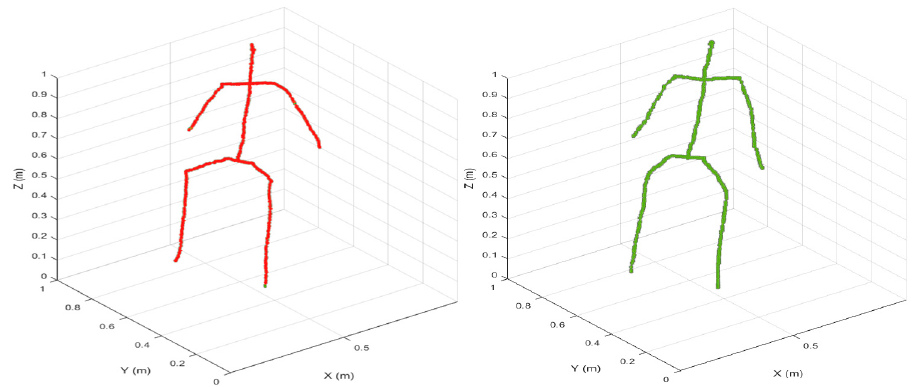
Figure 16. Pose estimation of sitting position.